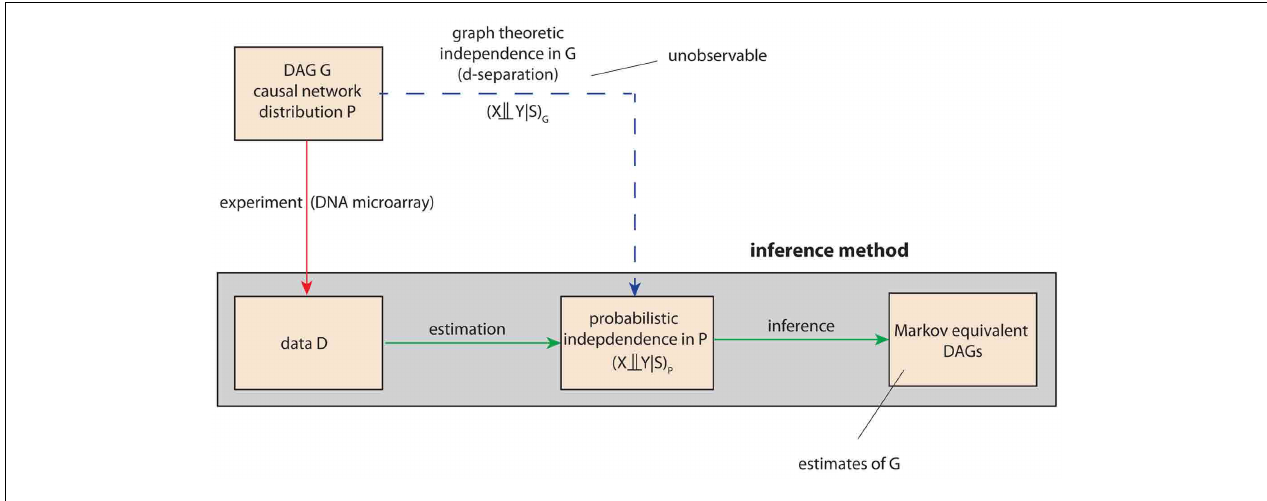
inferential, or theoretical (unobservable) steps. For notational simplicity, we use also in the inferential step the symbol P instead of ¯ P to indicate an estimate of P